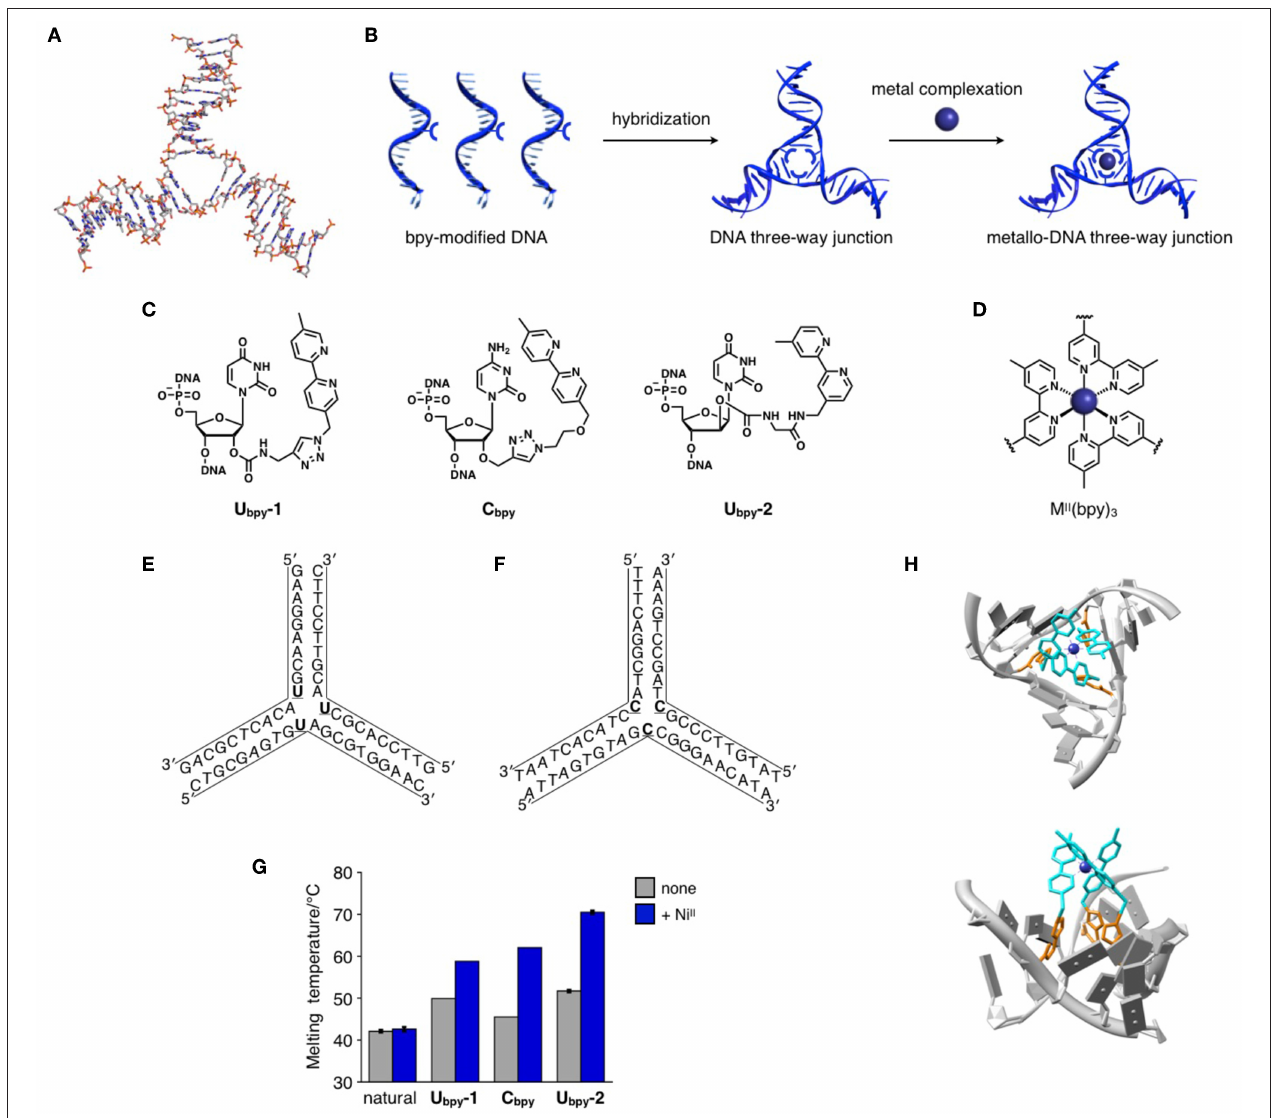
FIGURE 1 | (A) An ideal structure of an unmodified DNA three-way junction (3WJ) motif. Drawn based on a crystal structure (PDB ID: 1DRG) reported by Baldwin et al. (B) Construction of a DNA three-way junction motif bridged by a metal complex. (C) Molecular design of bipyridine (bpy)-modified nucleotides. (D) The structure of a representative metal complex formed at the core of the 3WJ. (E,F) Base sequences of DNA strands forming metal-bridged 3WJs. U represents U bpy -1 or U bpy -2 . C represents C bpy . (G) Melting temperatures of the 3WJs in the absence and in the presence of Ni II ions. [Ni II ]/[3WJ] = 1.1 (for C bpy ) or 1.0 (for the others). Note that the measurement conditions were slightly different form each other. For the details, see the original papers (Duprey et al., 2013; Stubinitzky et al., 2014; Takezawa et al., 2016). (H) Proposed structure of the Ni II (bpy) 3 complex at the core of the U bpy -1 -containing 3WJ. Only 3 -isomer is shown. Reproduced from a literature (Duprey et al., 2013) with permission from